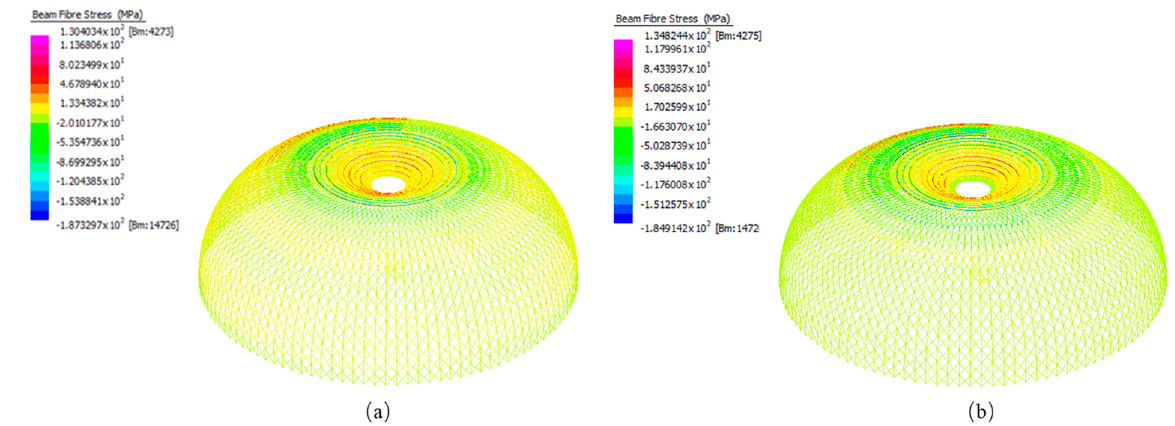
Figure 8. ( a ) Linear analysis of total fiber stress of straight member model under 1.2G + 1.5Q; ( b ) nonlinear analysis of total fiber stress of straight member model under 1.2G + 1.5Q.